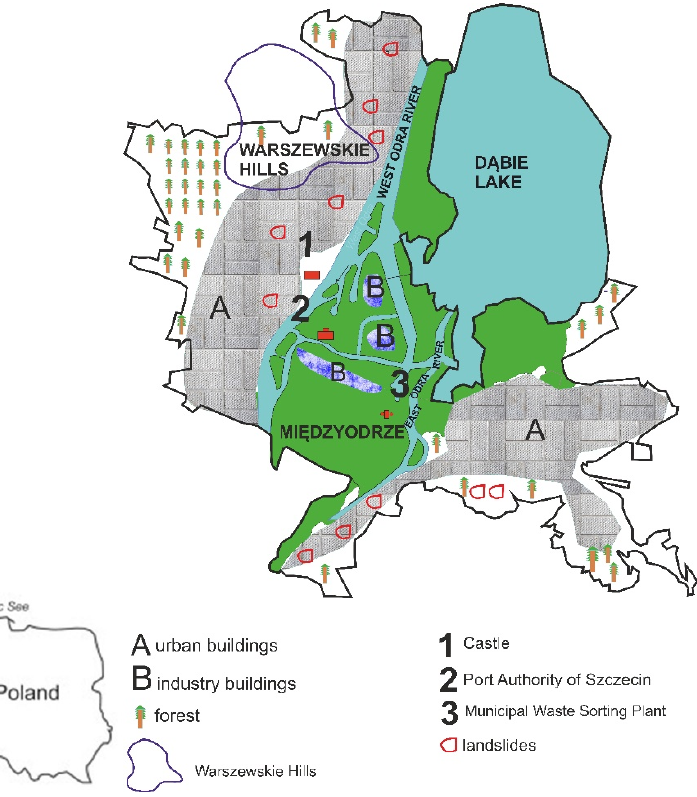
Figure 1. The area of Szczecin Mi ę dzyodrze and the location of Szczecin on a map of Poland. Table 1. Characteristic of a control and measurement system for 3D space